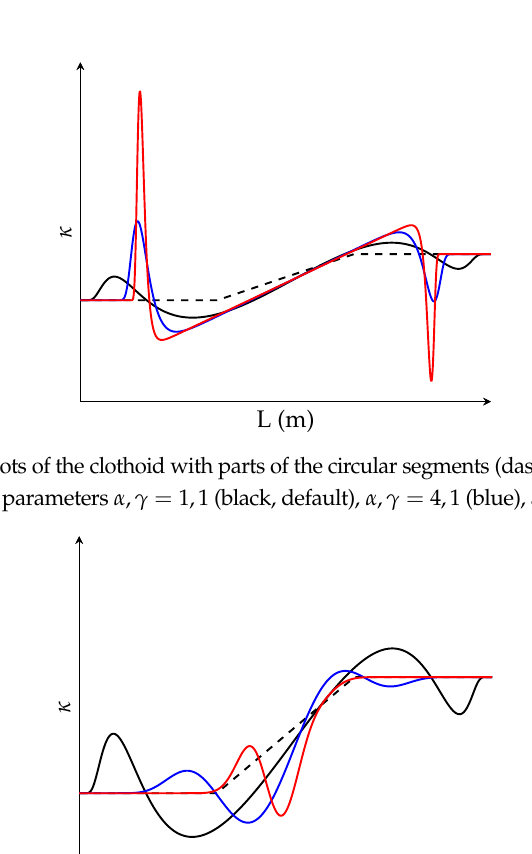
Figure 14. Curvature plots of the clothoid with parts of the circular segments (dashed) and blending splines in [ p 3 , q 3 ] for tightening parameters α , γ = 1,1 (black, Figure 15. Curvature plots of the clothoid with parts of the circular segments (dashed) and blending Figure 14. Curvature plots of the Figure 15. Curvature plots of the clothoid default), α , γ = 4,1 (blue), and α , γ = 10,1 splines in [ p 3 , q 3 ] for slope parameters β = 1.0 (black, default), β = 8.0 (blue), and β = 50.0 (red). clothoid with parts of the circular segments with parts of the circular segments (dashed) (red). (dashed) and blending splines in [ p 3 , q 3 ] for and blending splines in [ p 3 , q 3 ] for slope tightening parameters α , γ = 1,1 (black, parameters β = 1.0 (black, default), β = 8.0 Figure 16. Curvature plots of the clothoid default), α , γ = 4,1 (blue), and α , γ = 10,1 (blue), and β = 50.0 (red). with parts of the circular segments (dashed) (red). and blending splines in [ p 3 , q 3 ] for balance parameters λ = 0.5 (black, default), λ = 0.2 (blue), and λ = 0.8 (red).